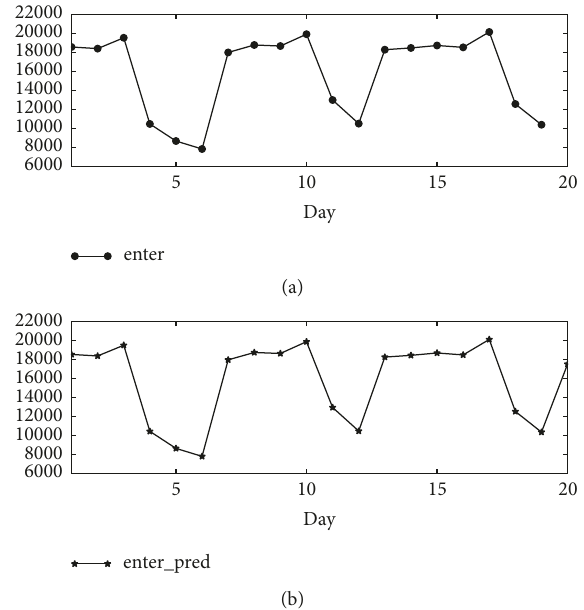
Figure 7: Prediction of daily entrance passenger flow of Dabaishu rail transit station (3 hidden